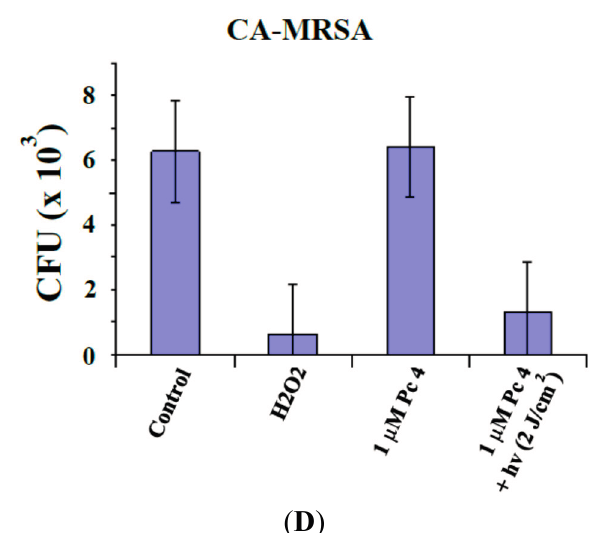
Figure 2. Pc 4-PDT kills S. aureus and inhibits colony formation. Bacteria cultures at equal concentrations were treated with various Pc 4 concentrations (100, 250, 500, 750, and 1000 nM) and incubated for 3 h and then followed by photoirradiation (see Experimental Section). The percentage of surviving cells from the PDT-treated cultures (MSSA, HA-MRSA and CA-MRSA) was normalized against cultures exposed to Pc 4 or light alone ( A ); The three strains are significantly affected by one single dose of Pc 4-PDT (1.0 µM and 2.0 J/cm 2 ) as indicated by counting colony formation assays ( B – D ). Values represent the mean from at least three independent experiments. Error bars indicate S.E. For all Pc 4-PDT-treated cultures vs. untreated cells, either light alone or Pc 4 alone, p < 0.005.